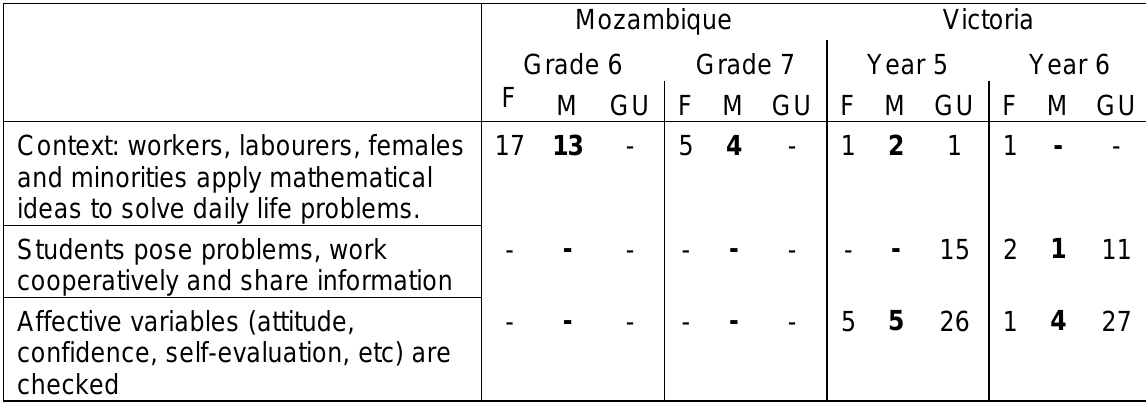
Table 7. Gender distribution among text features valuing accessibility in mathematics